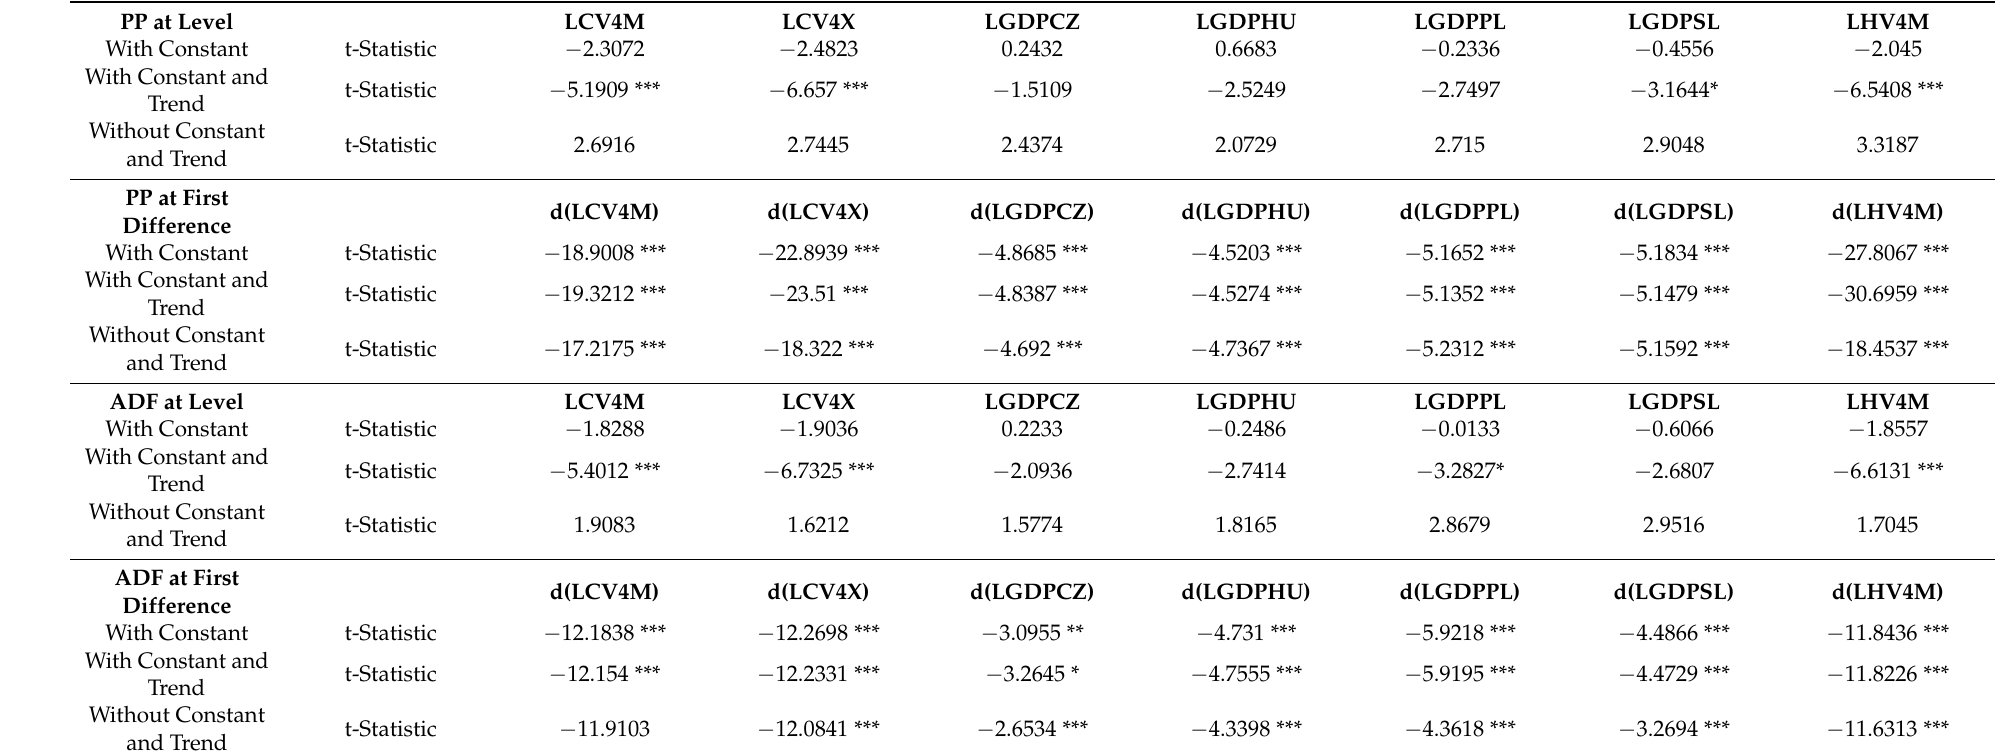
Table 2. Unit root test